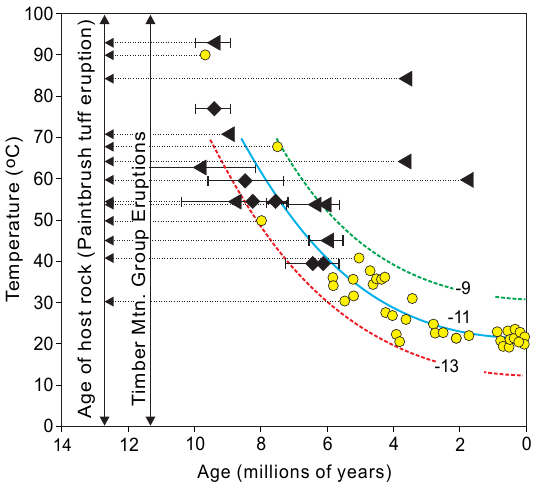
Figure 2. Fluid inclusion homogenization temperatures and tem- peratures calculated from calcite δ 18 O values (from Whelan et al., 2003). Fluid inclusion temperatures tightly constrained by 235 U / 207 Pb ages are plotted as black diamonds. Arrows indicate temperatures for which a 235 U / 207 Pb age provides only a min- imum age for calcite. Error bars are shown at 2 σ . Temperatures calculated from calcite δ 18 O values and constrained by U–Pb or U-series ages are shown as circles. Curves are best fits to the tem- peratures calculated from calcite δ 18 O values for deposition from waters with δ 18 O =− 13‰, − 11‰, or − 9‰. (Copyright 2003 by the American Nuclear Society, La Grande Park, IL,